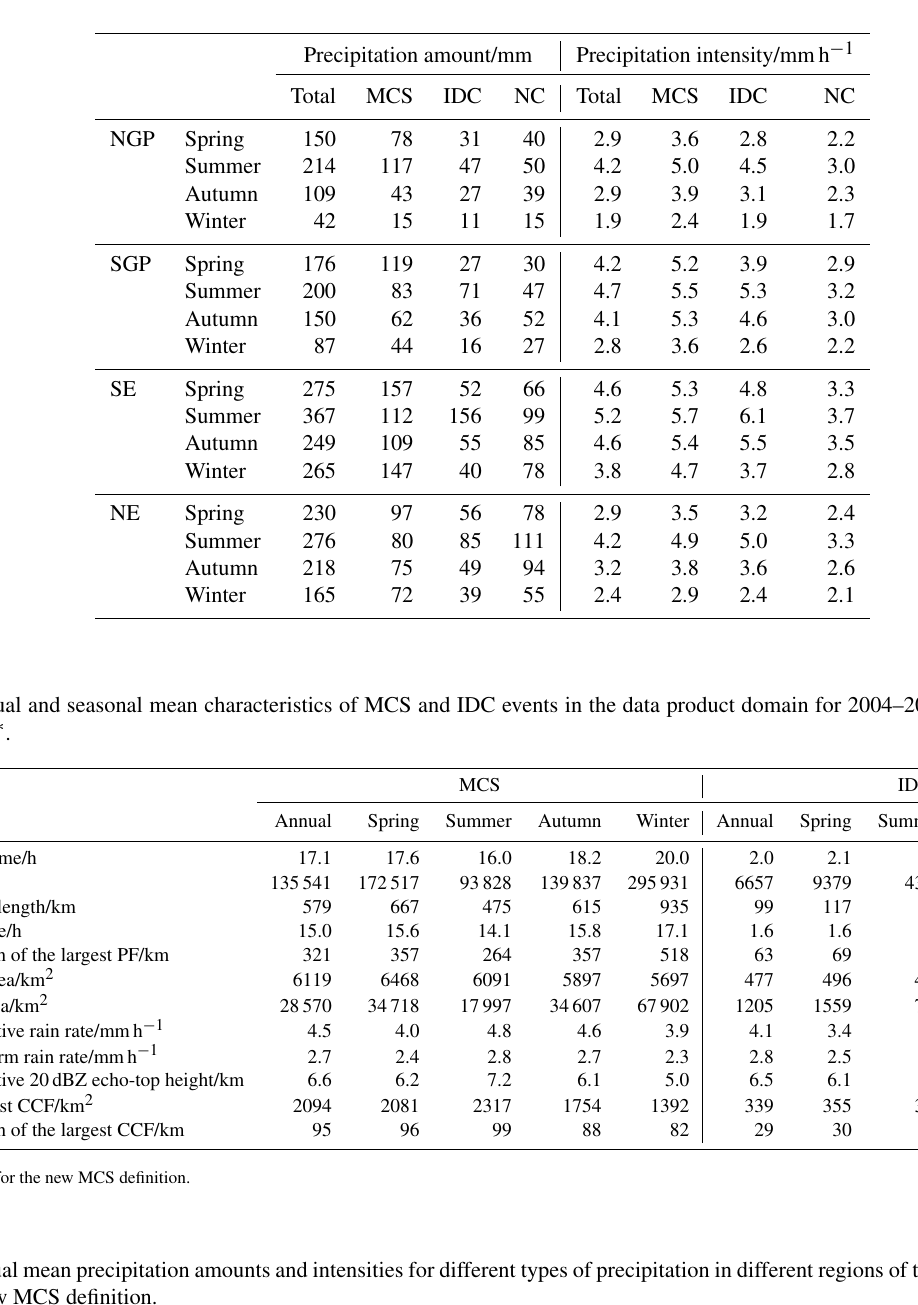
Table A4. Annual mean seasonal precipitation amounts and intensities for different types of precipitation in different regions of the US for 2004–2017.